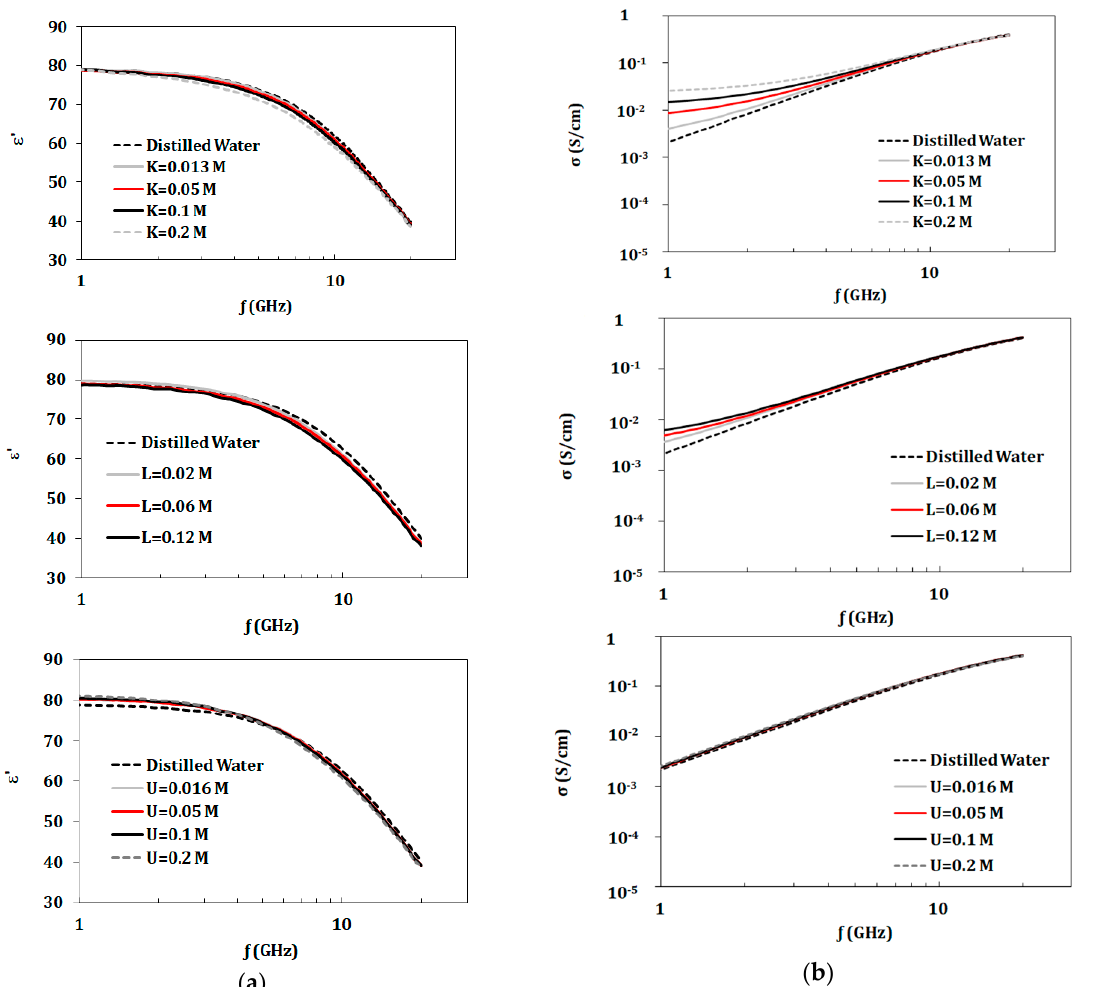
Figure 3. Measured dielectric properties for KCl, lactic acid, and urea solutions at ion concentrations 0.01 to 0.2 mol/L at temperature 23 °C in the range of 1–20 GHz: ( a ) dielectric constant and ( b ) conductivity. In all figures in this paper, “K” refers to KCl, “L” to lactic acid, “U” to urea, and “M” refers to mol/L.